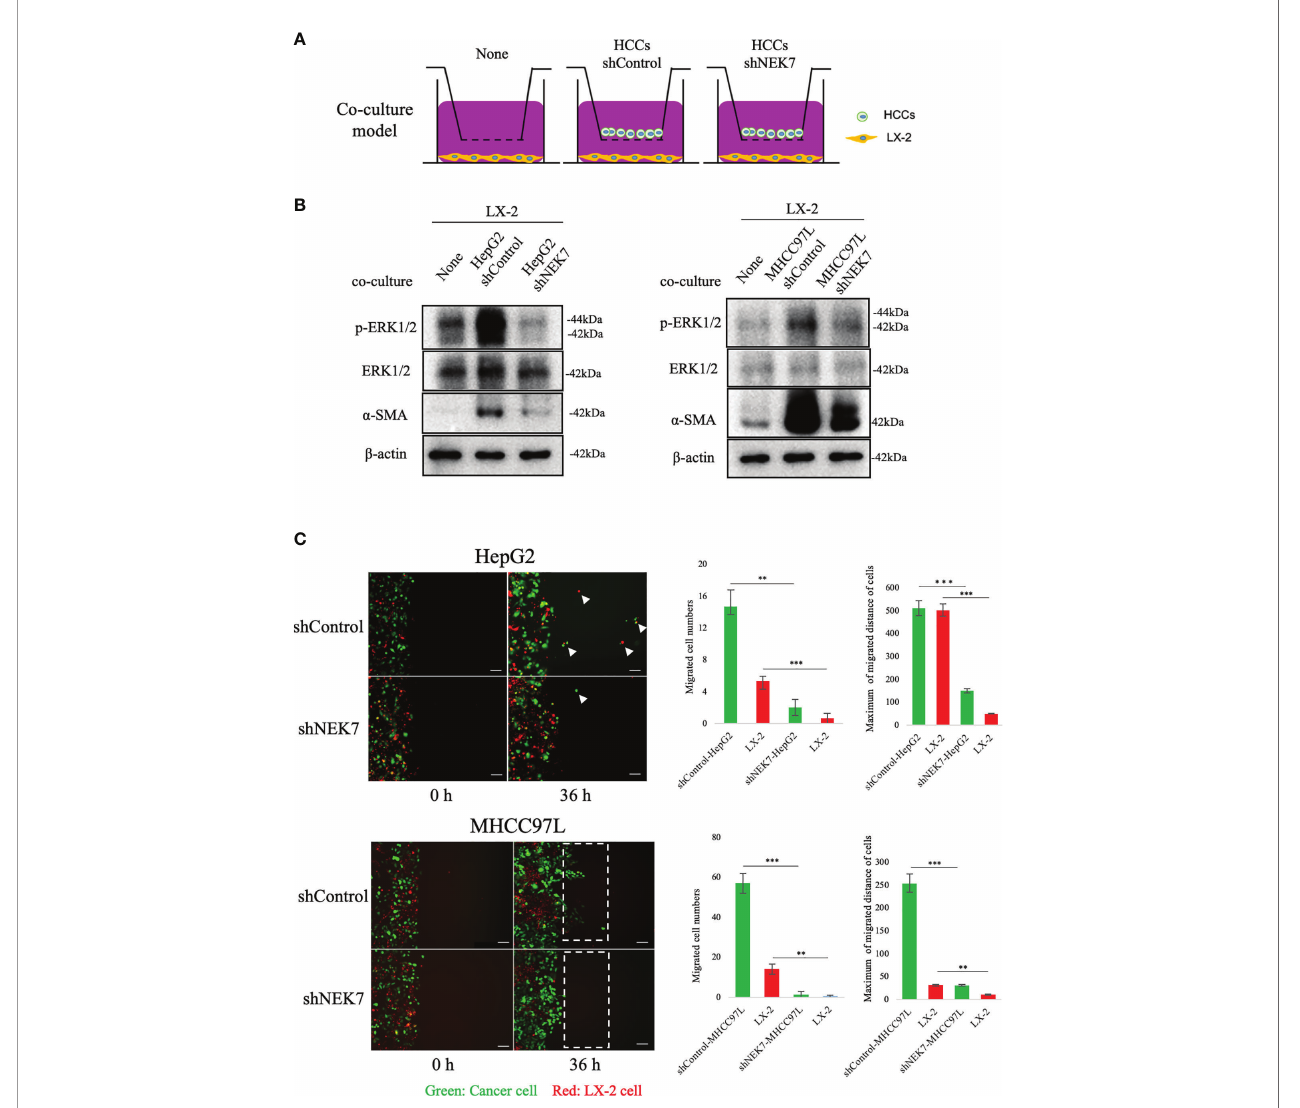
FIGURE 5 | NEK7 promoted cancer – stromal interaction by activating HSC. (A) In indirect coculture experiments, fi rst HSCs were seeded, and 24 h later, medium was replaced and transwell chambers (3- m m pores; Becton Dickinson) were placed in 24-well dishes, and then cells were seeded into the transwell chambers. After incubation for 2 days, HSCs in the lower chamber were collected and total protein was extracted. (B) Western blot of ERK1/2, p-ERK1/2, and a -SMA levels in HSCs, alone, or after coculture with HCCs. (C) shControl or shNEK cells direct the coculture model, coculture promoted the migration of both cancer cells and HSCs, meanwhile downregulation of NEK7 impaired the migration ability. Original magni fi cation: ×100. Scale bars = 100 m m. ** p < 0.01, *** p <